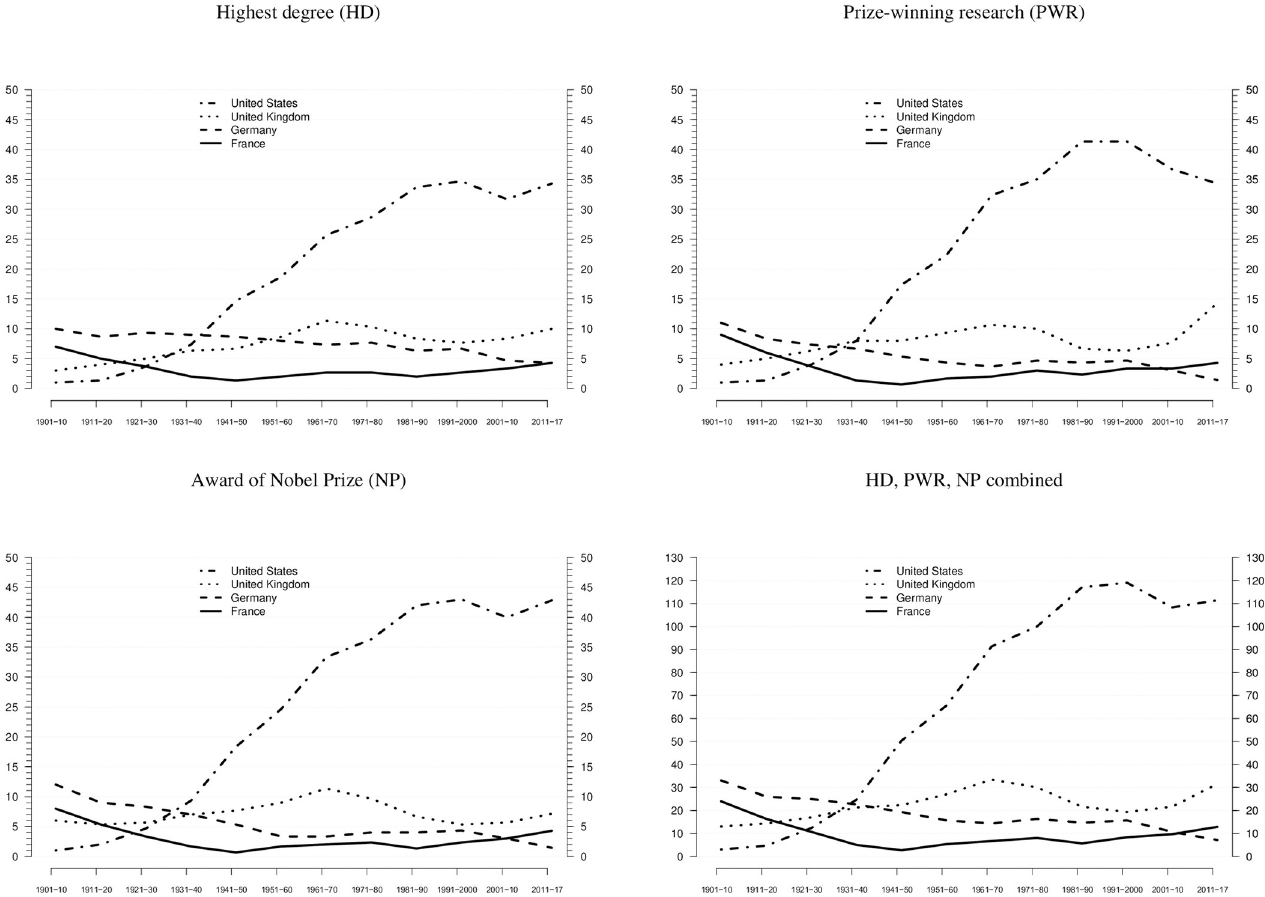
Fig 1. National distribution of Nobel laureates. Absolute frequencies of Nobel laureates across the four major countries, based on three career events (HD, PWR, NP). All observations refer to consecutive 10-year NP periods. Distributions in HD and PWR also are mapped onto NP periods. Lines are smoothened, using 3-period moving averages. The final period of 2011–2017 is weighted and thus comparable to earlier 10-year periods. Data from S1 Table are used.